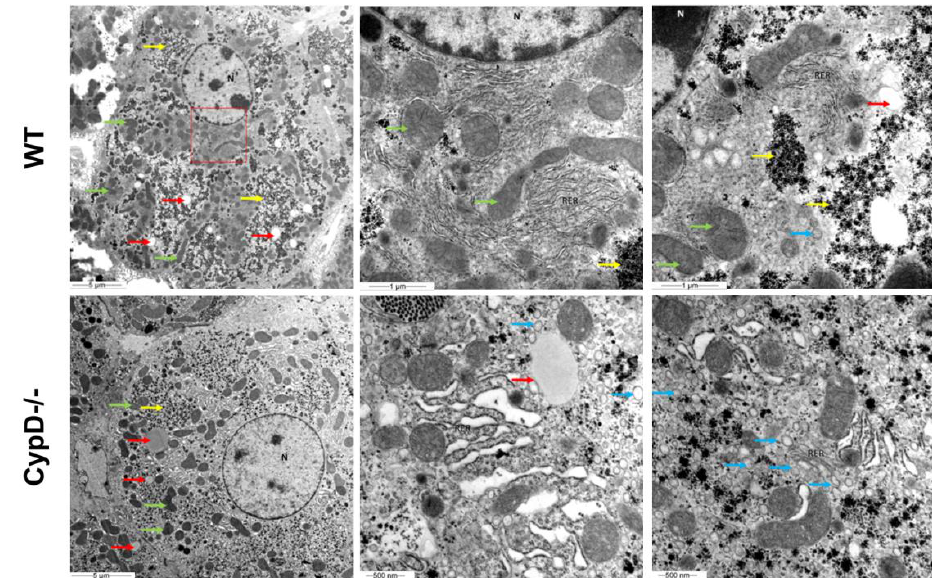
Figure 6. Observations on the fine structures of hepatocytes. N: nuclei, RER: rough endoplasmic reticulum, green arrows: mitochondria, yellow arrows: glycogen granules, red arrows: lipid droplets, blue arrows: vesicles.